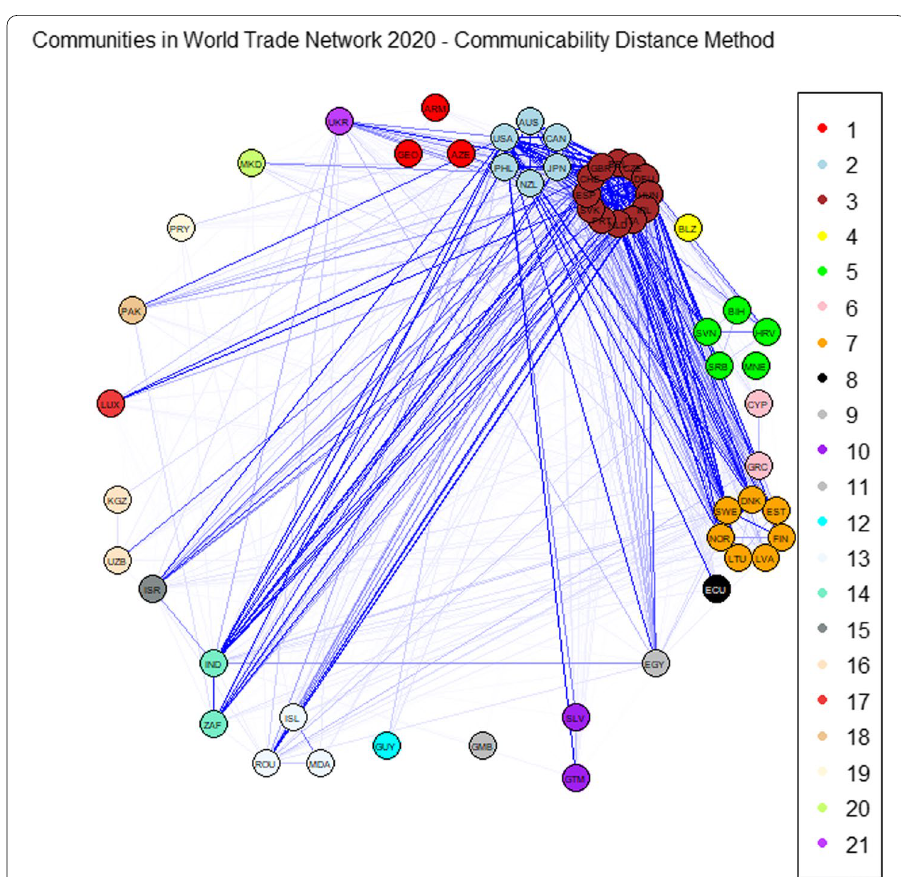
Fig. 3 Community graph obtained with the communicability distance method in 2020